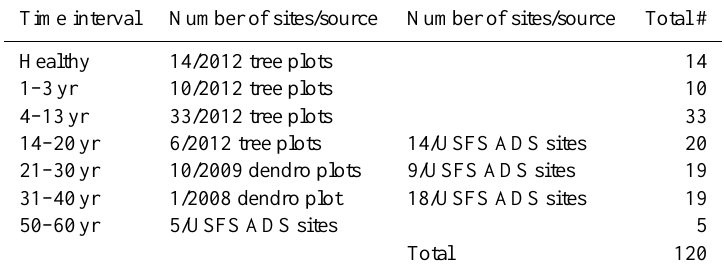
Table 1. The number and source of MPB outbreak locations utilized by time interval or time since MPB